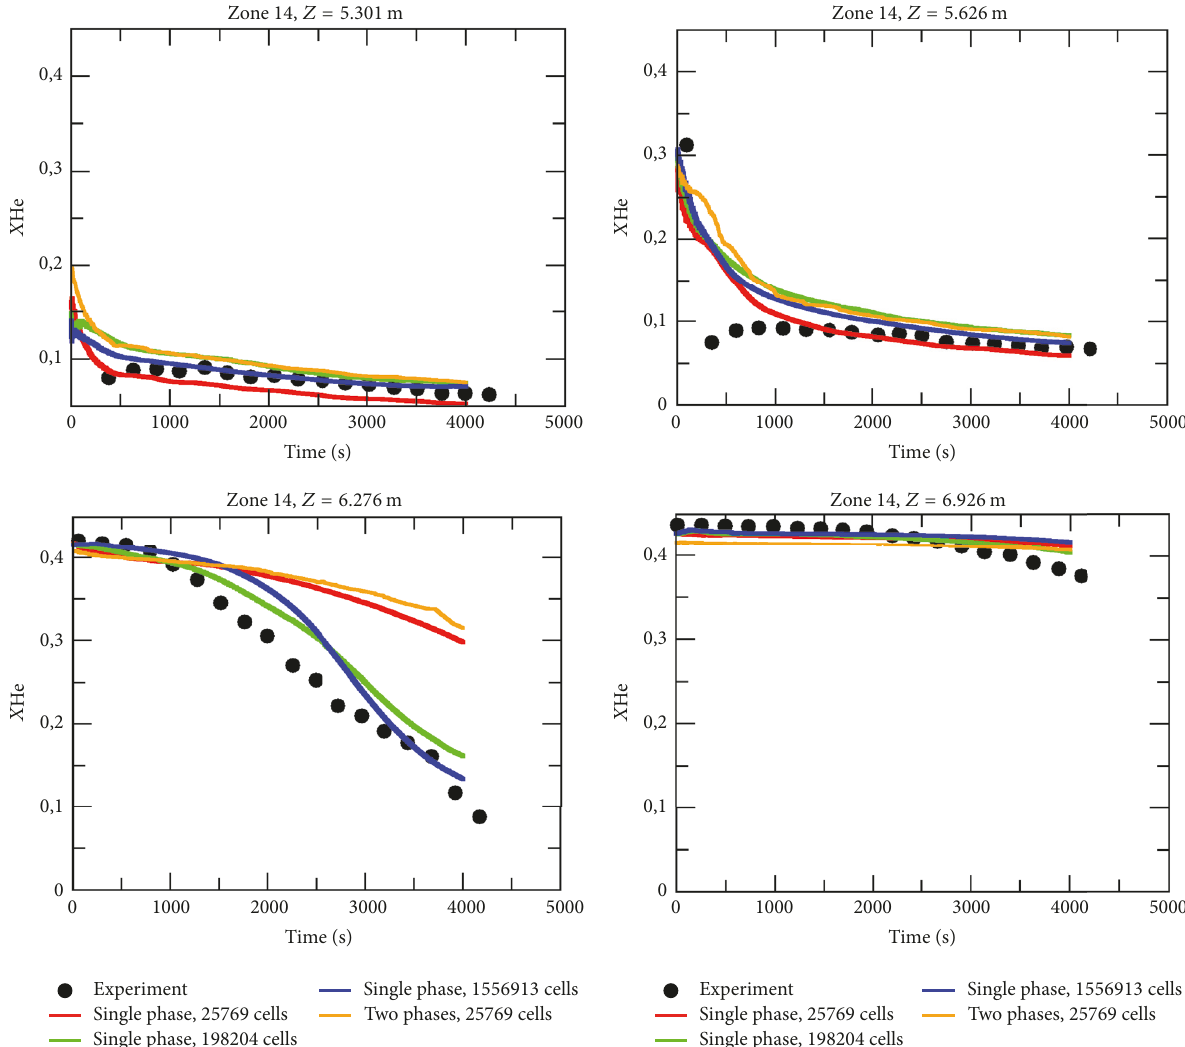
Figure 4: Helium concentration along the time for probes on zone 14 in PANDA ST1 7; “single phase” stands for Code Saturne and “two phases” stands for NEPTUNE CFD code.